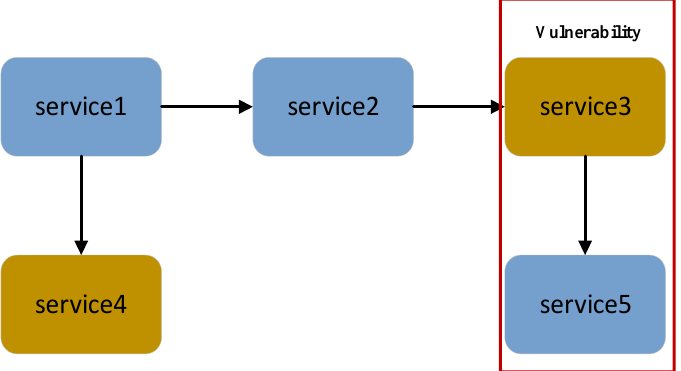
Figure 2. Graphic example of Definition 4.